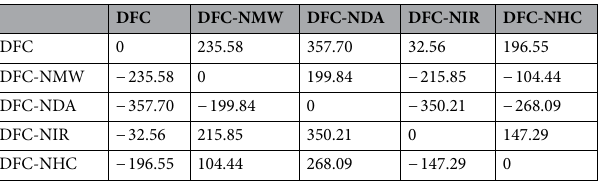
Table 6. McNemars test results for Oberpfaffenhofen dataset achieved by using 100 training samples per class.